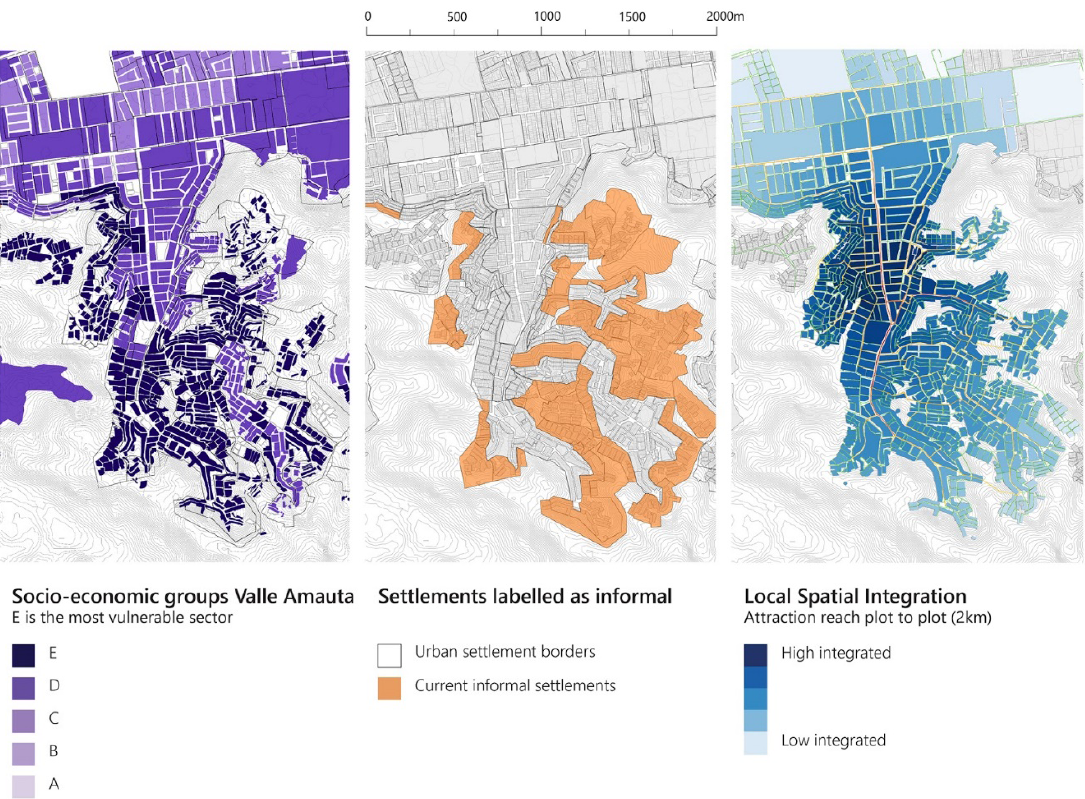
Figure 3. Distribution of socioeconomic groups and areas labelled as informal and formal in Metropolitan Lima. Source: Authors, based on data from INEI (2016) and Municipality of Lima (2013a).